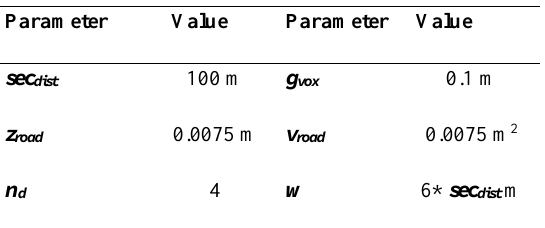
Table 1. Values of parameters involved in the methodology. The validation of the process is performed on the entire dataset. Since the road alignment is obtained from the roadway boundaries, and the ground truth of the alignment is known but not the roadway width, the validation process is applied to the alignment.